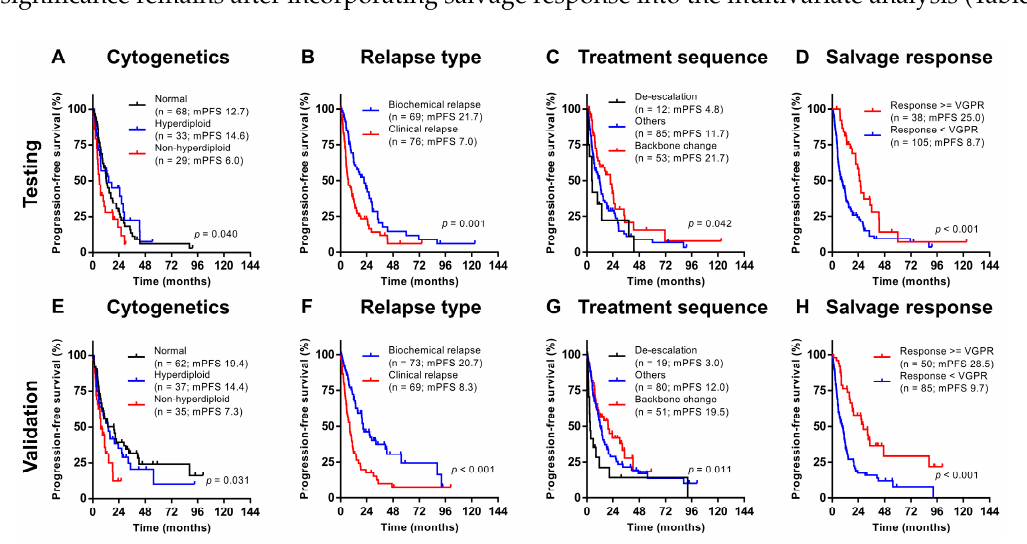
Figure 3. Overall survival categorized according to different prognostic factors in the testing (( A ) cytogenetics; ( B ) relapse type; ( C ) treatment sequence; ( D ) salvage response) and validation (( E ) cytogenetics; ( F ) relapse type; ( G ) treatment sequence; ( H ) salvage response) cohorts.